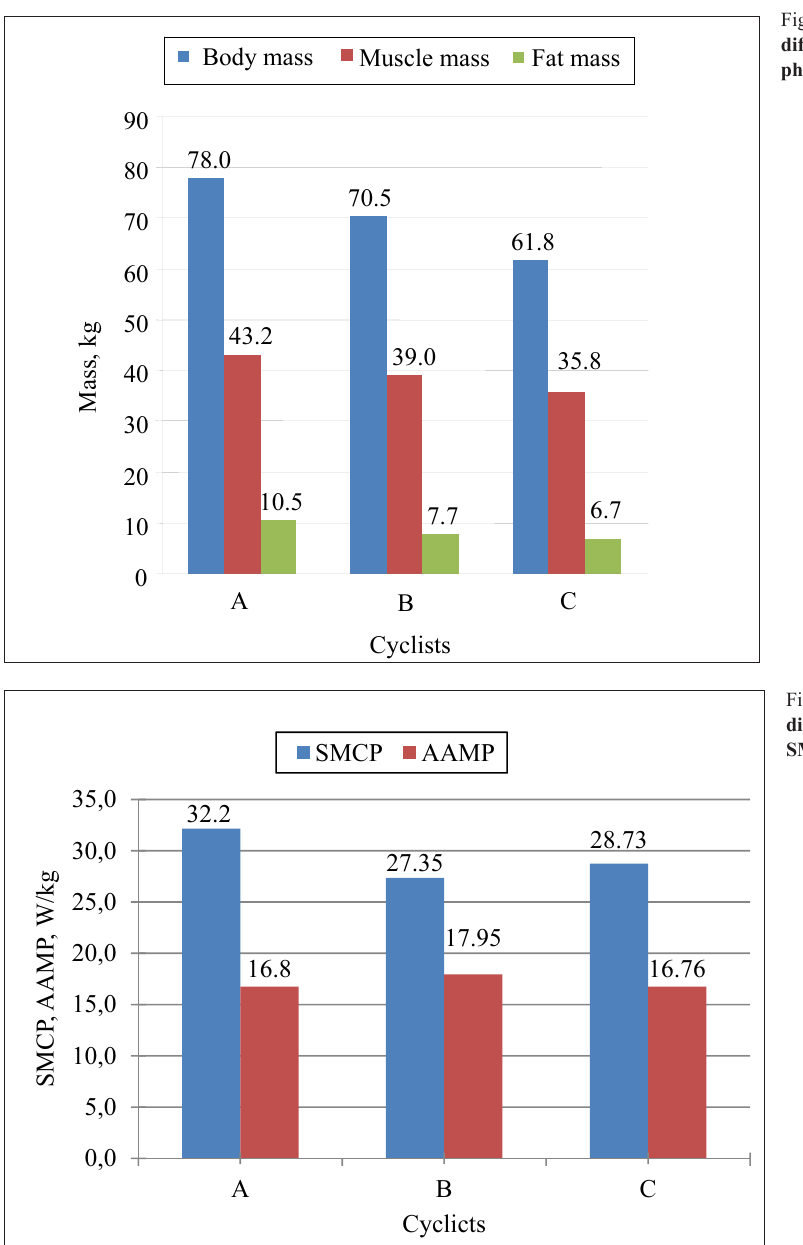
Figure 2. Comparative characteristics of different specialization female cyclists’ SMCP and